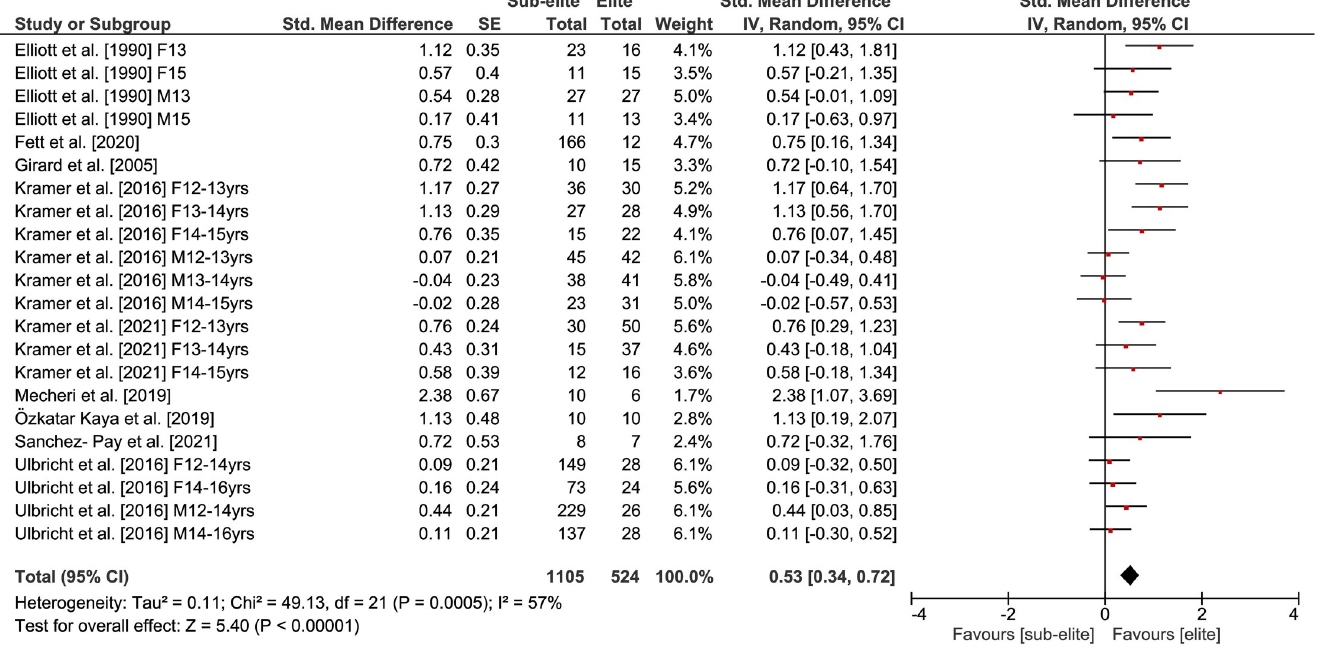
Fig 2. Differences in measures of lower extremity muscle power by competition level (i.e., elite vs. sub-elite tennis players). CI = confidence interval, df = degrees of freedom, SE = standard error, IV = inverse variance.